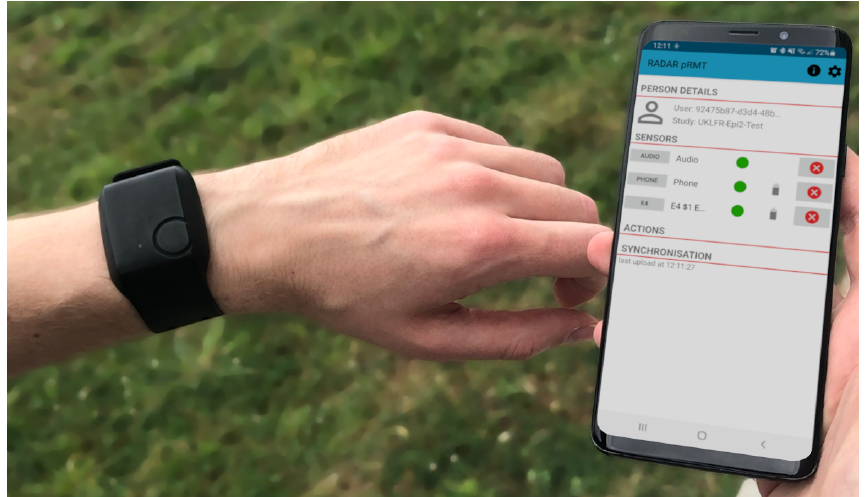
Figure A1. The Empatica E4 wrist-worn wearable device used in this study ( left ), and the Android phone application that connects to the wearable via Bluetooth and records the data stream ( right